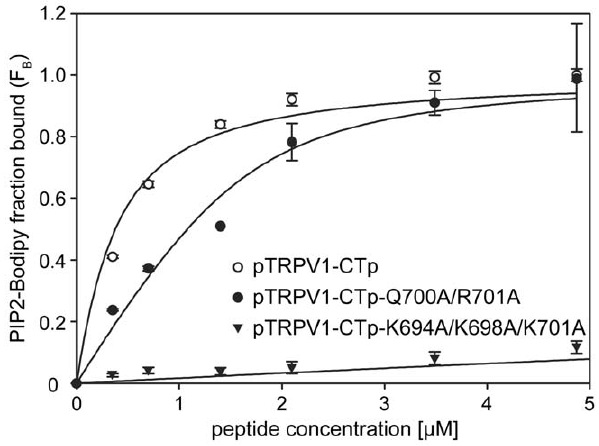
Figure 6. PIP2 binds to the C-terminal proximal region of TRPV1. Steady-state fluorescence anisotropy measurement of in- teraction between fluorescently labeled phosphatidyl inositol-4, 5- bisphosphate (PIP2-Bodipy) and synthetic peptide corresponding to the cytoplasmic tail at the C terminal proximal region K688-K718 of TRPV1 (pTRPV1–CTp) or its Q700A/R701A (pTRPV1–CTp-Q700A/R701A) and K694A/K698A/K710A (pTRPV1–CTp-K694A/K698A/K710A) mutant vari- ant, respectively. PIP2-Bodipy (10 nM) was titrated with with